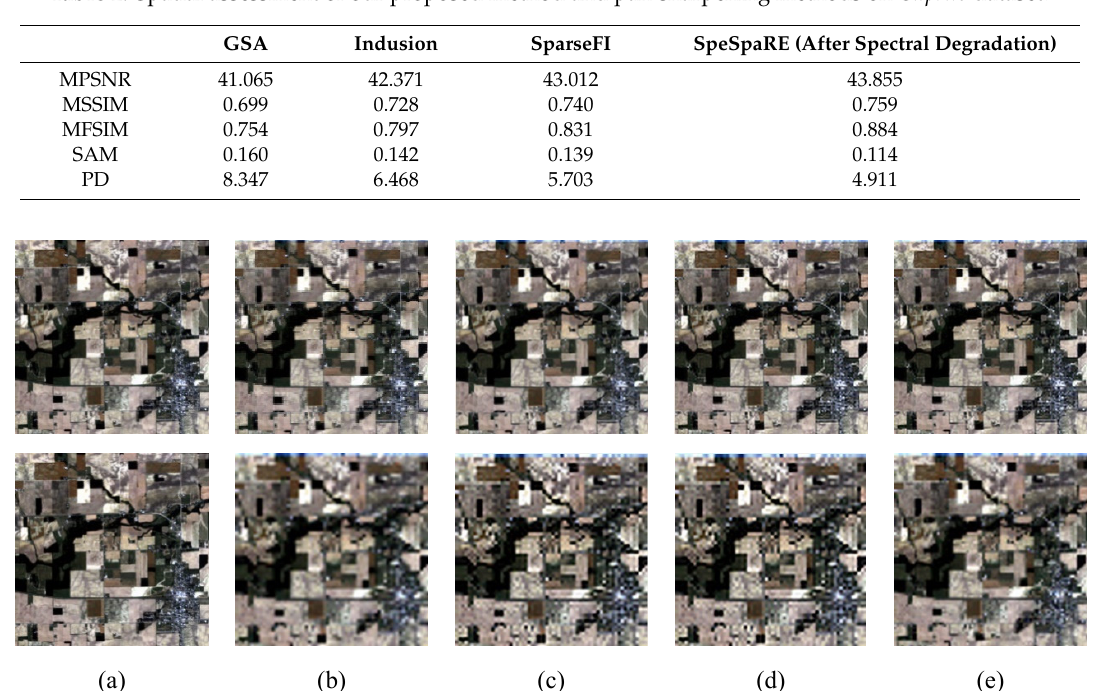
(e) Figure 5. Spatial resolution enhancement comparison on Cuprite dataset, from top to bottom are the comparison with down-sampling factor of 2 and 4. ( a ) Reference HRI, spatial resolution enhancement results of ( b ) GSA method, ( c ) Indusion method, ( d ) SparseFI method and ( e ) Proposed J-SpeSpaRE method (after spectral degradation). Spectral super-resolution methods are used to evaluate the effectiveness of spectral resolution enhancement. For fair comparison, the result of our proposed method J-SpeSpaRE should be spatially degraded. The spectral assessments on both Indian pines dataset and Cuprite dataset are listed in Table 3 and Table 4, respectively. The best evaluation results are written in bold letters. The compared spectral resolution enhancement methods include Arad and SREM. In Tables 3 and 4, our proposed method achieves better or more competitive results than the compared methods. Figures 6 and 7 show visual comparison of Indian pines dataset and Cuprite dataset, where the spectral enhancement results of band 550 nm, 750 nm, and 1,500 nm are presented. Arad’s method is designed based on sparse representation framework where a high-resolution spectral dictionary is trained using hyperspectral priors. Spatial constraints are ignored in Arad’s method, so it suffers from serious spatial and spectral distortions. A transformation matrix between input MSI and the desired HSI is estimated in SREM method, where spatial correlation is not used because of the pixel by pixel processing. The proposed J-SpeSpaRE method shows superior comparison results than Arad’ method and SREM. Spatial observation model and spectral observation model are designed to acquire high spectral resolution dictionary and high spatial resolution abundances in an alternative approach.